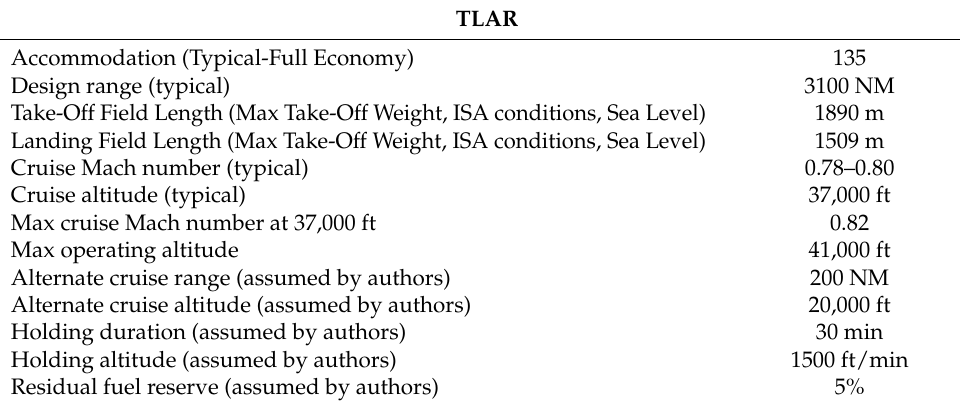
Table 2. Main data concerning the A220-300, reprinted from